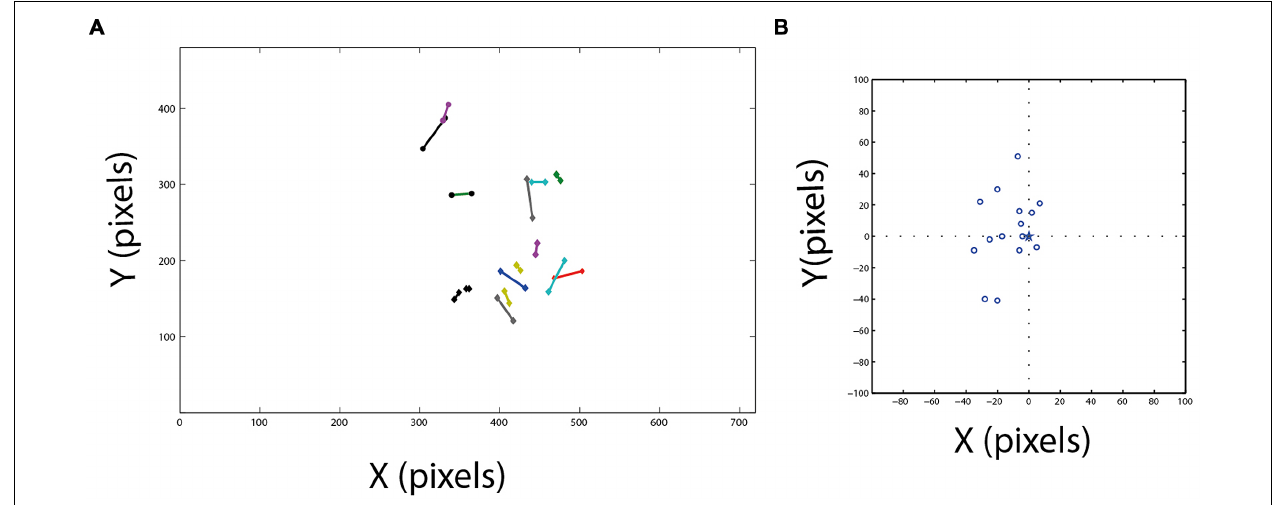
FIGURE 5 | Comparison between area centralis and the functional fovea. (A) Fifteen estimated projections of area centralis on the video frame are shown together with the corresponding estimations of the functional fovea. Corresponding pairs are connected with lines. (B) The